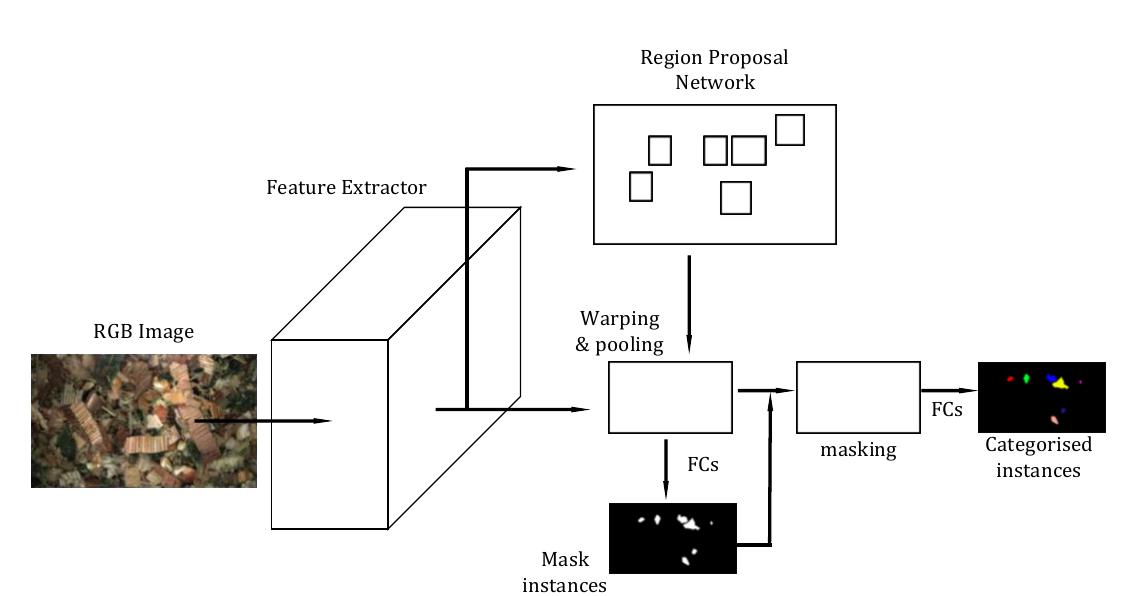
Figure 6. The Multi-task Network Cascade (MNC) architecture, as in Region-based Fully Convolutional Network (R-FCN), an image is passed through a number of convolutional layers and RoIs are found with an RPN. Features are extracted from the RoIs via RoI warping and pooling. Class agnostic masks are founding from the features that are being passed through FC layers. The masks are classified from the RoI features through another set of FC